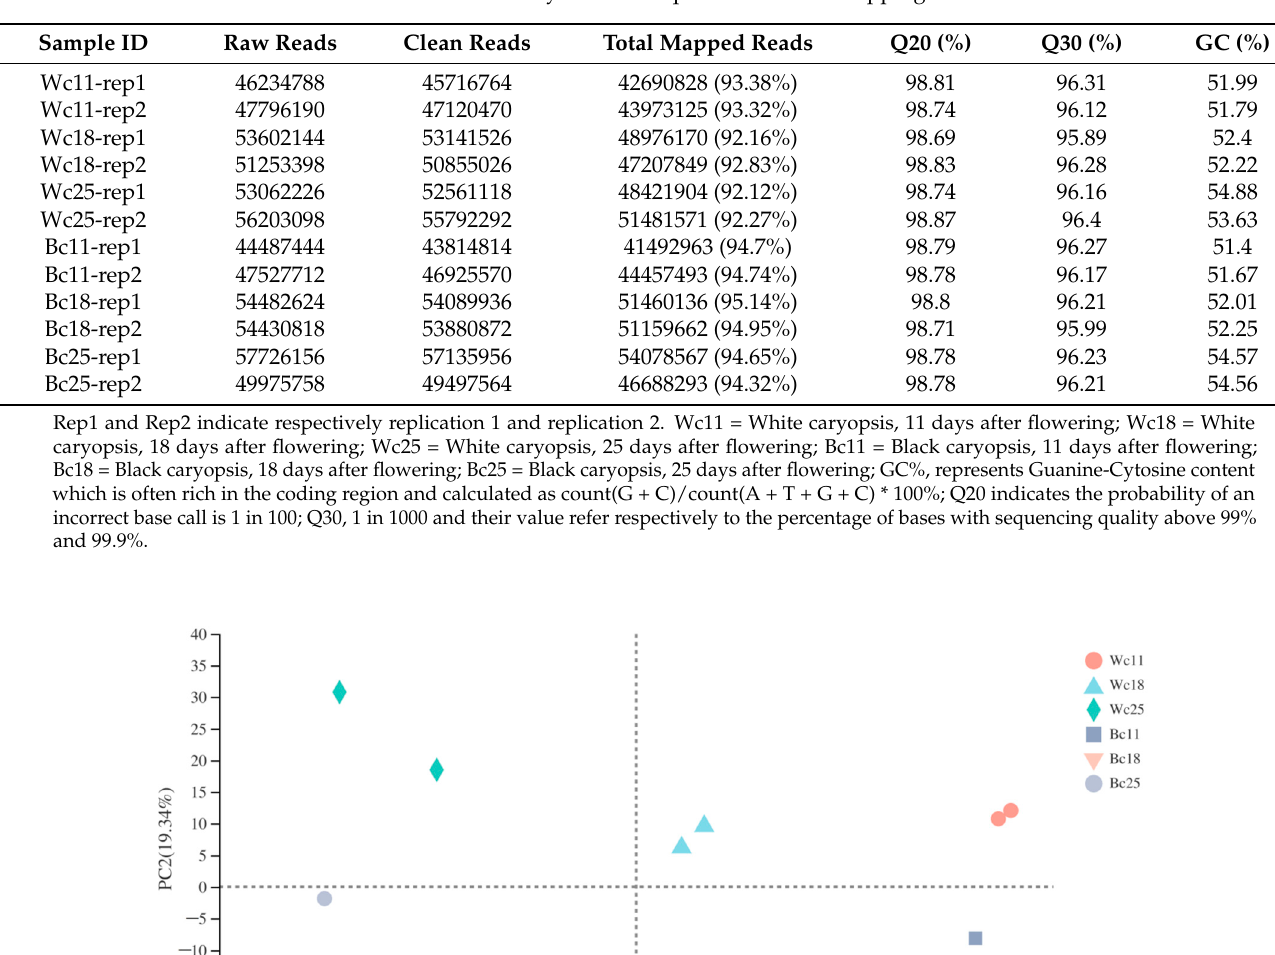
Table 2. Summary of RNA seq data and reads mapping.